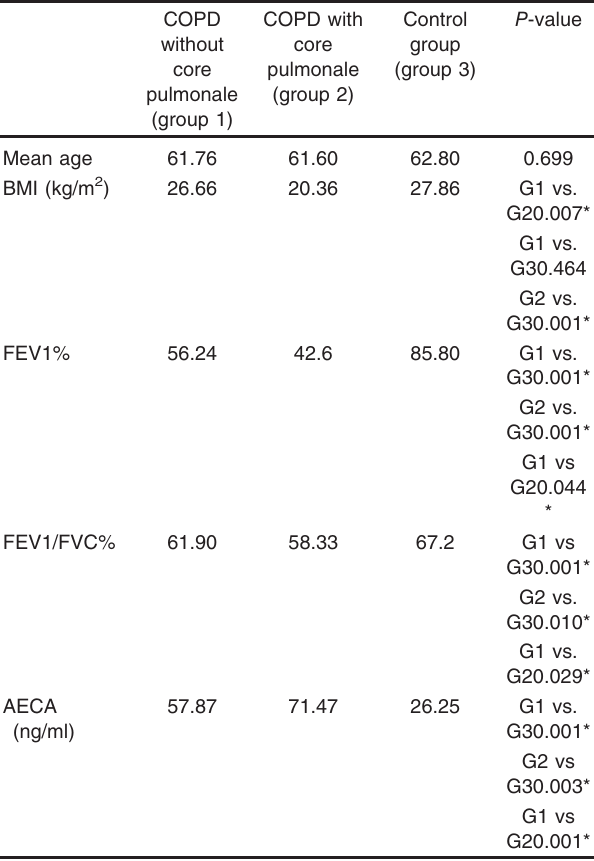
Table 1 Statistical comparison between different groups with regard to age, BMI, FEV1, FEV1/FVC and AECA level